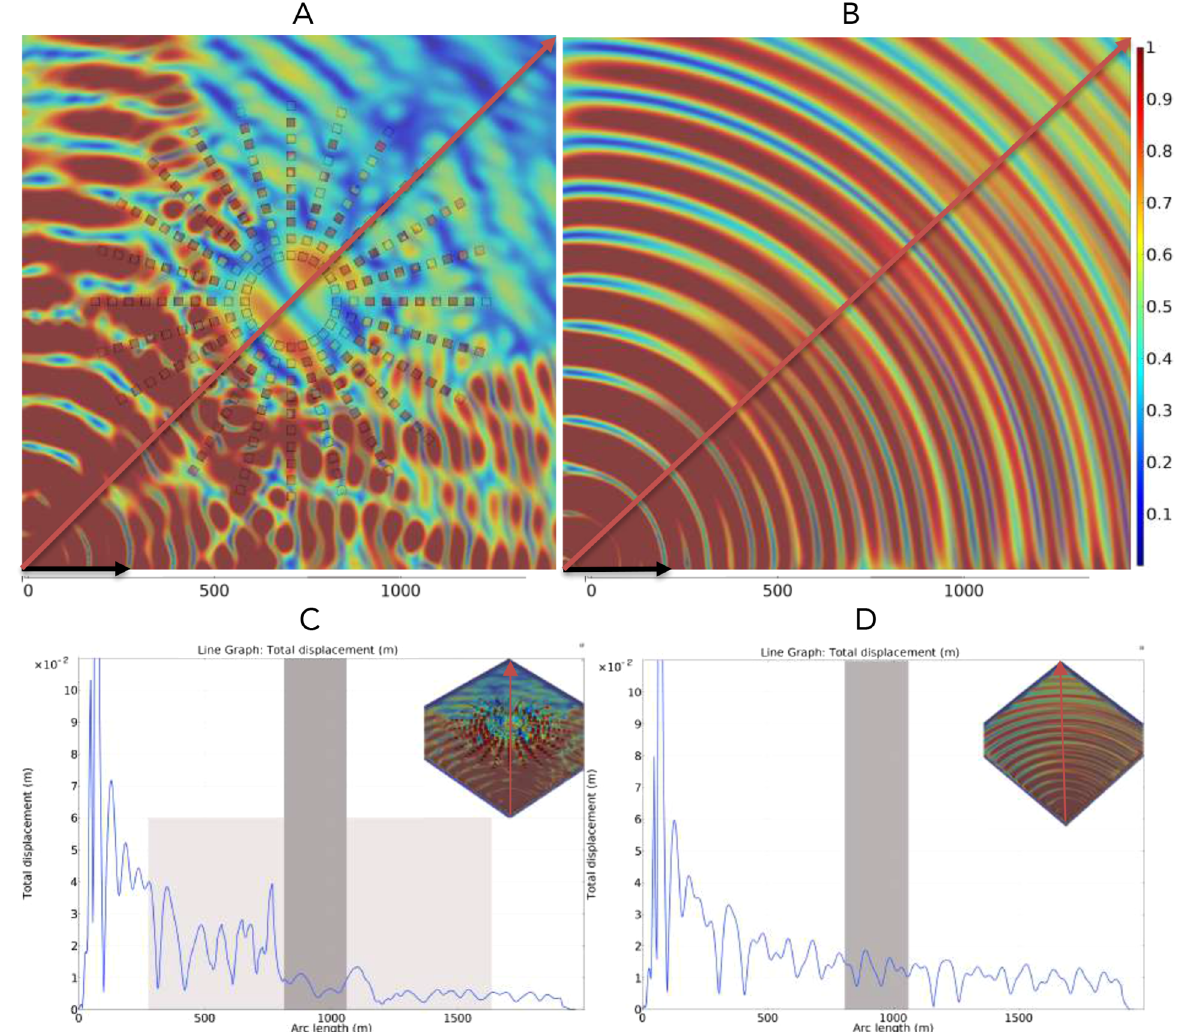
Fig. 4. Scattering of the metacity cloak (consisting of concrete buildings) by a point source at frequency 10 Hz (A), (C) and benchmark in concrete plate (B), (D); the seismic source is situated at a distance of 700 m from the centre of the cloak along a radial direction marked by red segment in (A), where the arc length is the Euclidean distance; Insets in (C) and (D) are the 3D views of (A) and (B), respectively. Blue curve in (C) and (D) shows pro fi le of magnitude of total displacement fi eld computed along the red segment in (A) and (B), respectively. Dark grey region in (C) marks the protected region inside the cloak with around 40 percent of reduction of the magnitude of total displacement in comparison with same region in (D). Light grey region in (C) marks the cloak